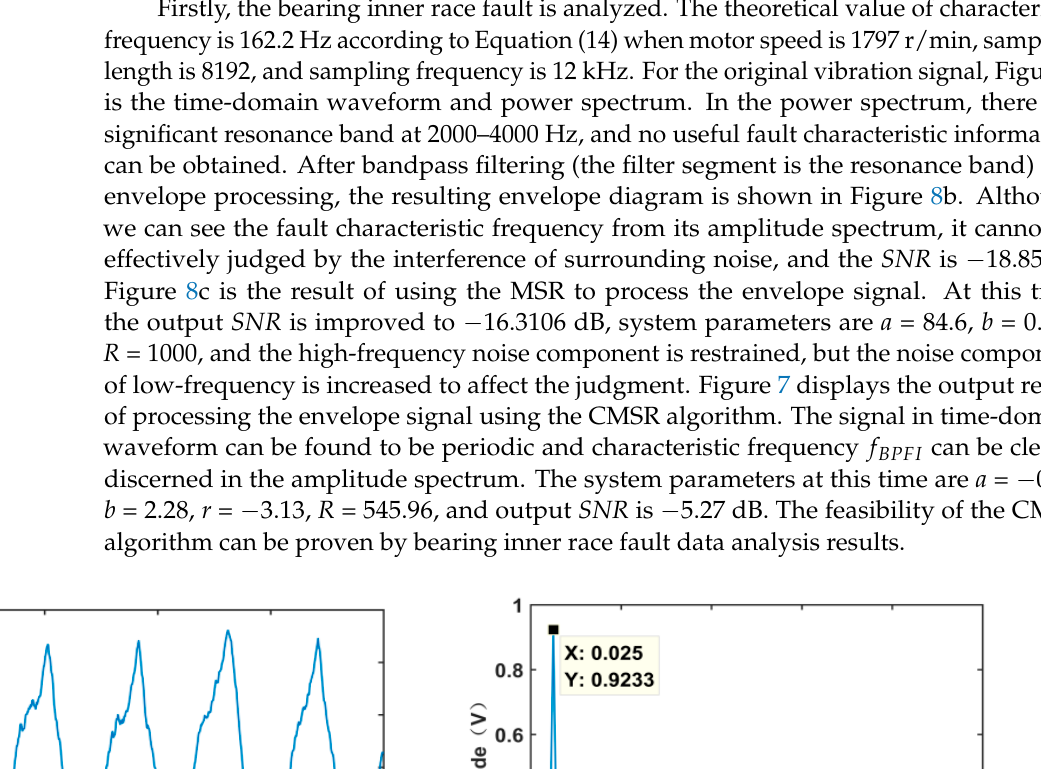
algorithm can be proven by bearing inner race fault data analysis results.